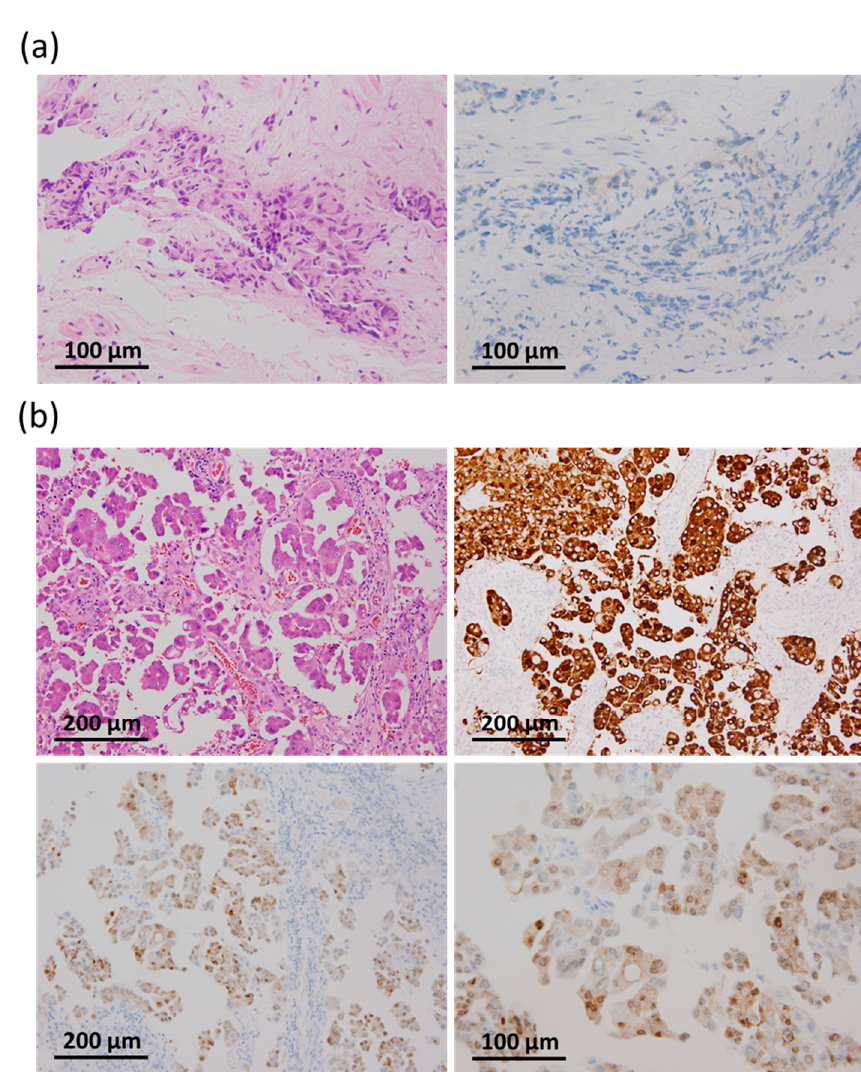
Figure 2. Disconcordant results of BRAF VE1 immunohistochemical (IHC) staining and molecular analysis in two lung adenocarcinoma samples. ( a ). A false negative case. Bronchial biopsy with BRAF V600E mutation detected by DNA sequencing shows weak positive cytoplasmic staining in only 10% of tumor cells. Hematoxylin-eosin staining (left panel) and VE1 immunohistochemical staining (right panel) ( b ). A false positive case. The tumor carried an ALK fusion detected by ALK IHC. Upper panels show hematoxylin-eosin staining (left) and ALK IHC (right). Lower panels for VE1 IHC show moderate positive staining in both the nucleus and cytoplasm in 80% of tumor cells (left, 200×; right, 400×).